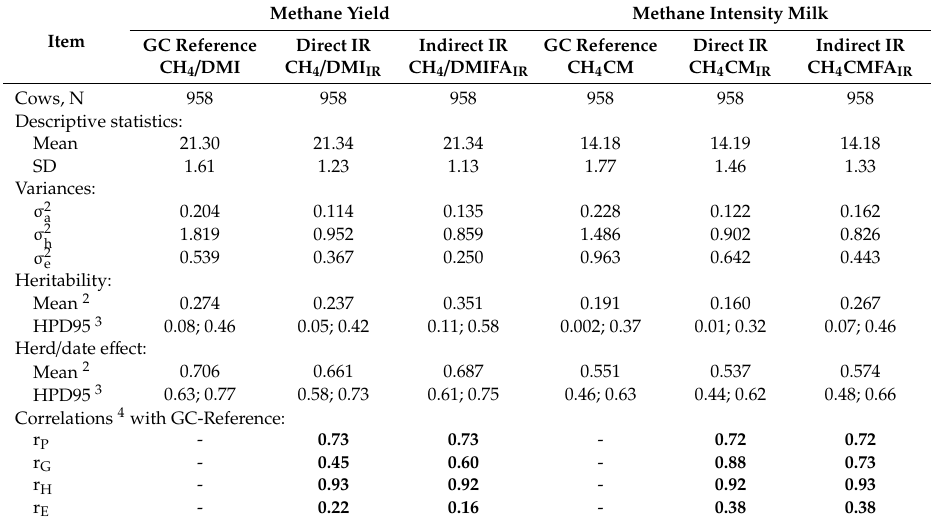
Table 2. Estimates of additive genetic ( σ 2 a ), herd / date ( σ 2 ), and residual ( σ 2 e ) variances, heritability, h and herd / date e ff ect of GC reference values based on GC FA profile, and of direct IR and indirect IR predictions of methane yield and methane intensity milk based on milk FTIR spectra, and additive genetic (r G ), herd (r H ), residual (r E ), and phenotypic (r P ) correlations between GC reference and IR predicted methane emission traits 1 .